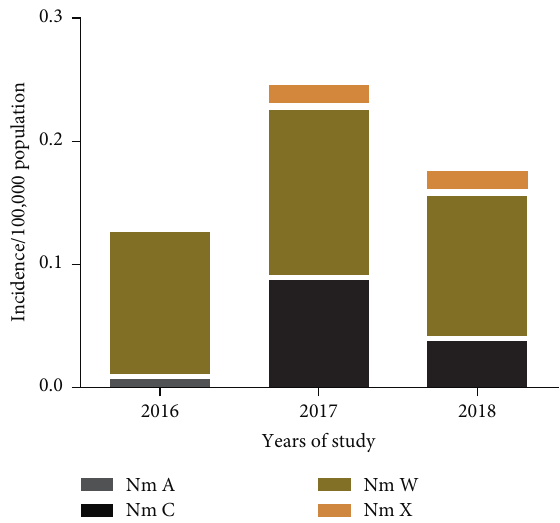
Figure 1: Incidence (per 100,000 inhabitants) of the different N. meningitidis serogroups in the Republic of Benin from 2016 to 2018.